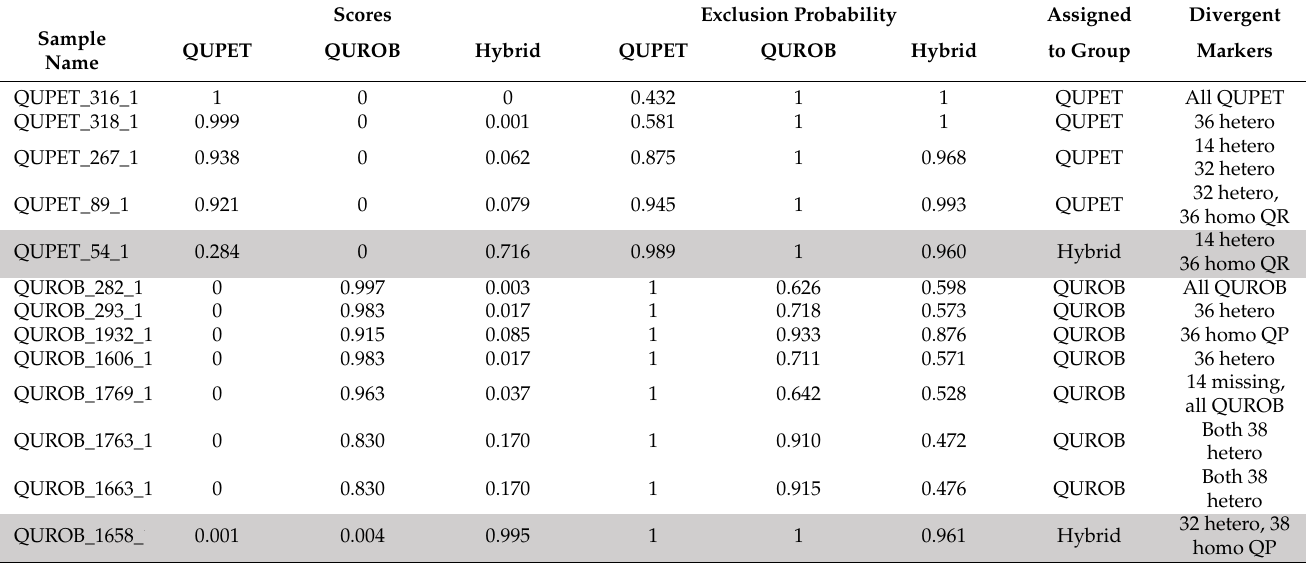
Table 4. Result of the self-assignment test with the individuals selected from the references of Q. robur and Q. petraea . The false assigned specimens are given in grey. The markers in the last column are only given with the number not with the full marker name (Table 3). hetero = heterozygous, homo = homozygous, QP = Q. petraea , QR = Q. robur .